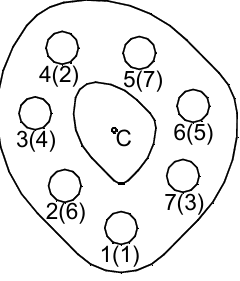
Figure 5. Location of the bolts in the plan of the contact surface between the joined elements.